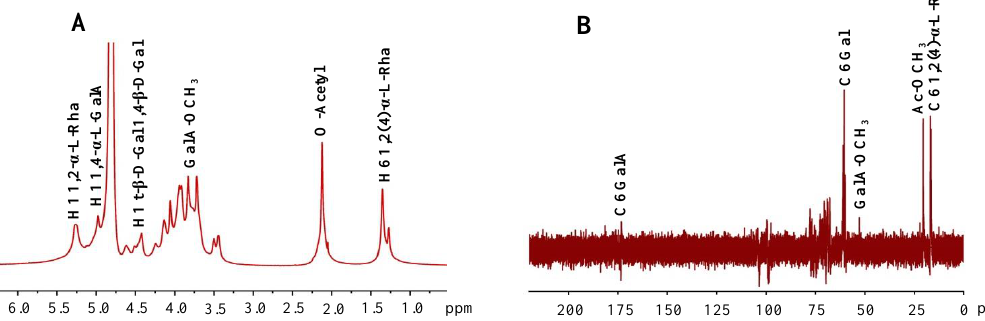
Figure 3. 1 H ( A ) and 13 C ( B ) NMR spectra of OPP-D.